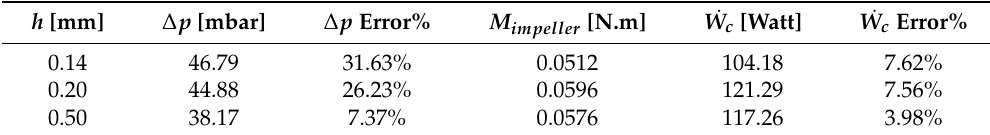
Table 6. Inlet height calibration for the TBP numerical model @ 18,500